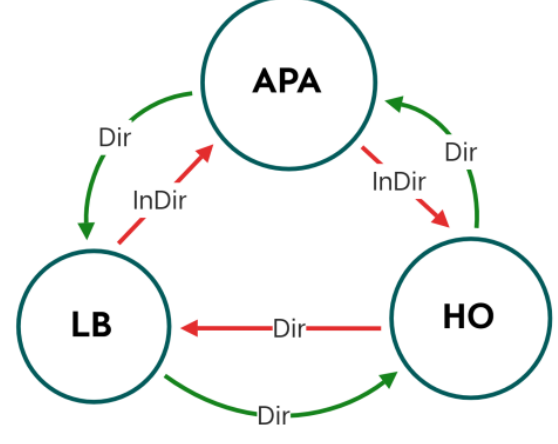
Figure 1. The relationship among LB, APA, and HO.